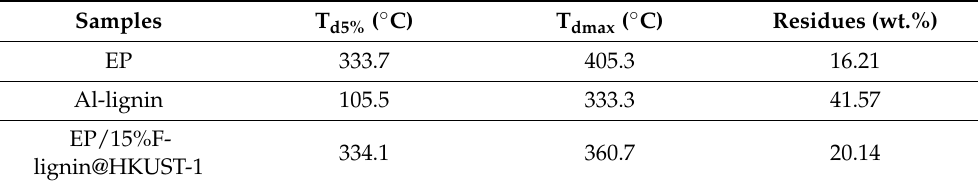
Table 1. TG data of EP, Al-lignin and EP composites under N 2 atmosphere. Samples